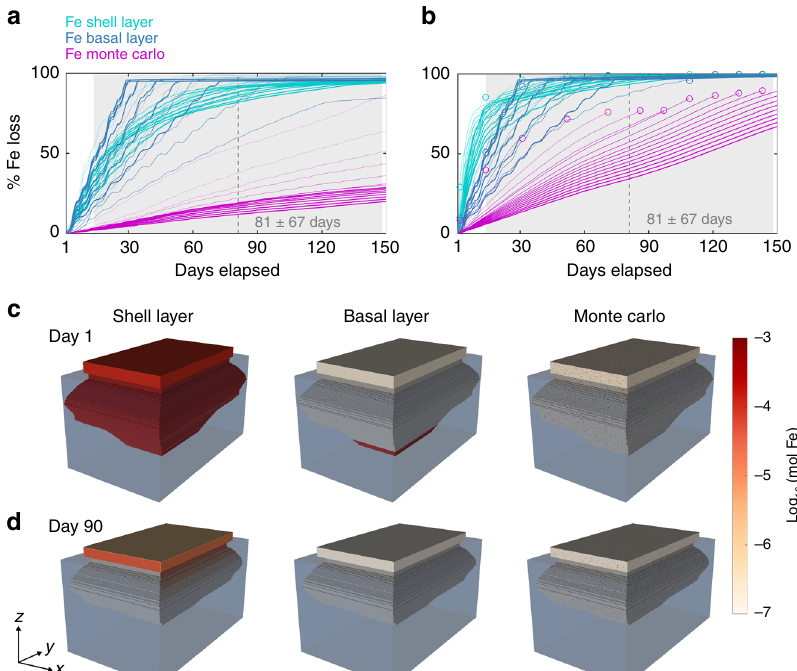
Fig. 2 Cumulative Fe release from different icebergs. Fe is initially distributed either randomly in a Monte Carlo simulation, concentrated in a layer of basal ice, or concentrated in a shell around the iceberg periphery. Icebergs of varying morphology, based on observed distributions, are released into Sermilik fjord at t = 0 days. a Mean net Fe loss from all icebergs within each Fe scenario. Days elapsed represents the model run length with mean iceberg residence time (dashed vertical line) ± standard deviation (shaded gray area) within Sermilik fjord shown for reference 46 . Thicker lines correspond to increasing iceberg length (from 50 to 1000 m). Wave melt is parameterized as previously 45 . b The same scenarios, but with an alternative parameterization for wave-melt driven iceberg erosion 50 . Open dots represent icebergs reaching a point of instability where rolling or disintegration becomes inevitable, which would likely accelerate melt and substantially redistribute any remaining shall/basal Fe. c Model run at t = 0 days for select shell, basal and Monte Carlo iceberg scenarios. d Model run at t = 90 days for the same shell, basal and Monte Carlo iceberg